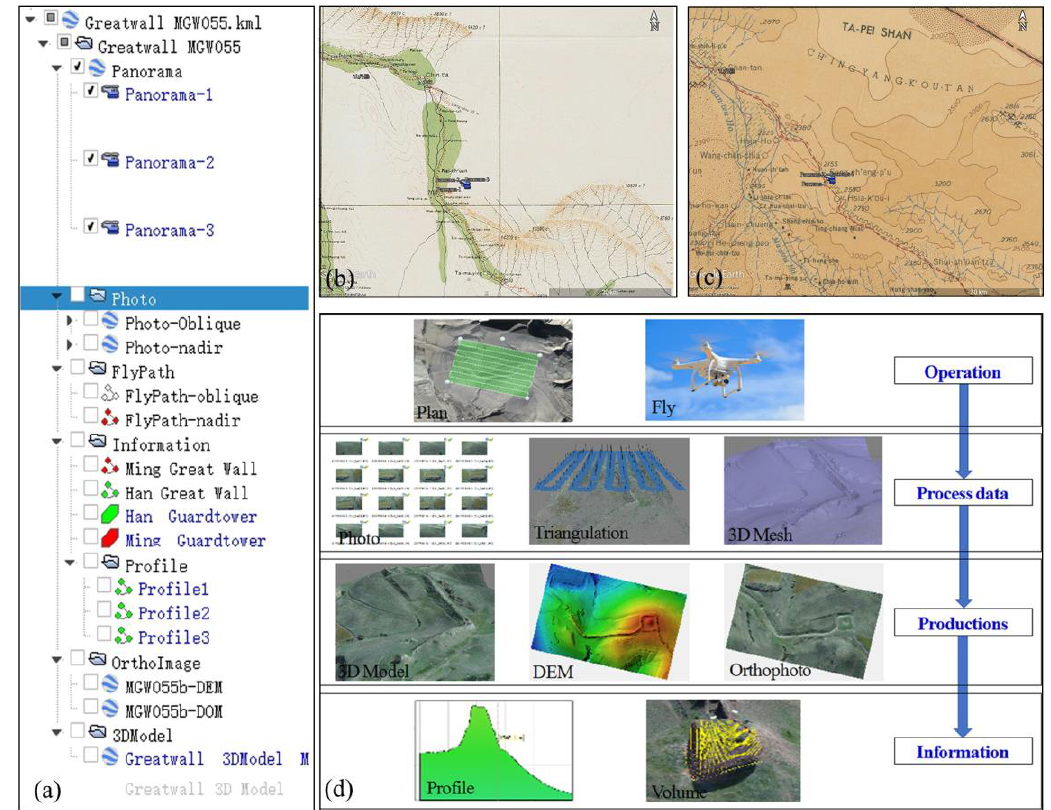
Figure 5. The integration of geospatial data of the Great Wall in Northwestern China. ( a ) The overall tree structure of KML layers in GE; ( b ) the archaeological maps made by Stein [94]; ( c ) the archaeological maps made by Hedin [95]; and ( d ) the operation flowchart for our UAV investigation. We deleted the photo layer in the supplementary file (KML S2) owing to the volume being too large to submit for peer